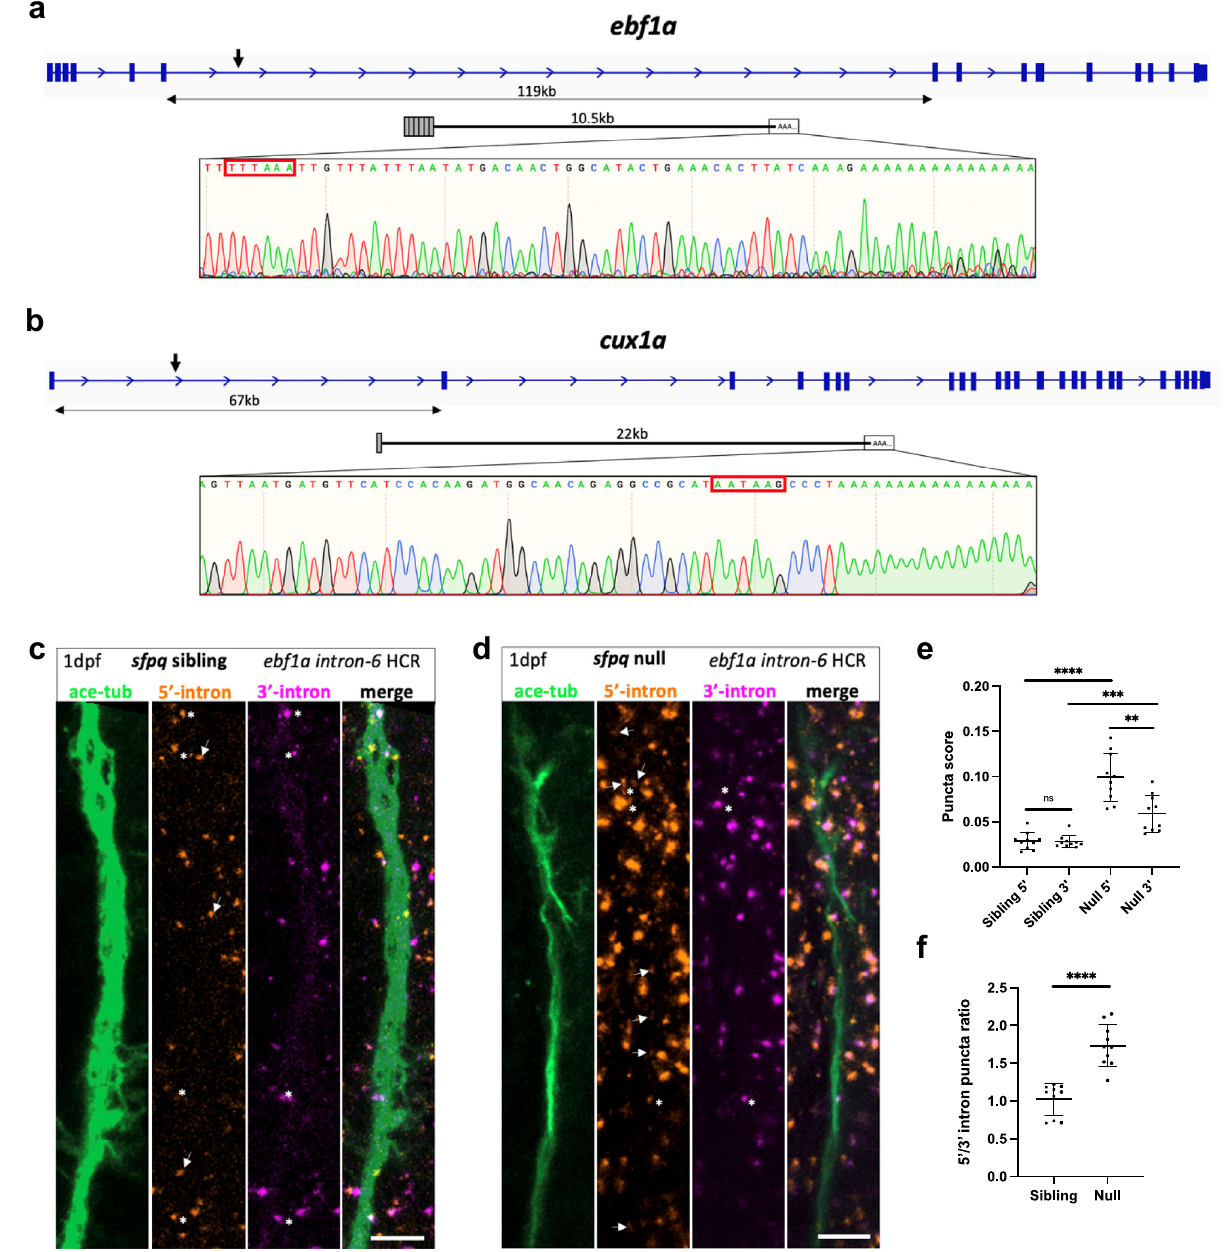
Fig. 6 | ALS PreT-IR transcripts are enriched in null neurites. a , b Sequencing traces from 3 ’ RACE products of PreT-IR transcripts for ebf1a ( a ) and cux1a ( b ), zebra fi sh homologues of ALS-affected EBF1 and CUX1 , show terminal intronic sequences with polyadenylation signals (red boxes) and start of the polyA tail. a ebf1a PreT-IR transcript comprises exons 1 – 6+10.5kb intron-6 and polyA tail. b cux1a PreT-IR transcript comprises exon 1+22kb intron-1 and polyA tail. c , d Confocalz-projections(10 μ m)of 1dpf/24hpf sfpq sibling( c )&null( d )embryo axons, immunolabelled by targeting acetylated-tubulin, and ebf1a intron-6 IR and PreT-IR transcripts labelled by HCR with probe sets targeting the 5 ’ -most 10kb of intron-6 (red) and the 3 ’ -most 10kb of intron-6 (magenta). Axons running